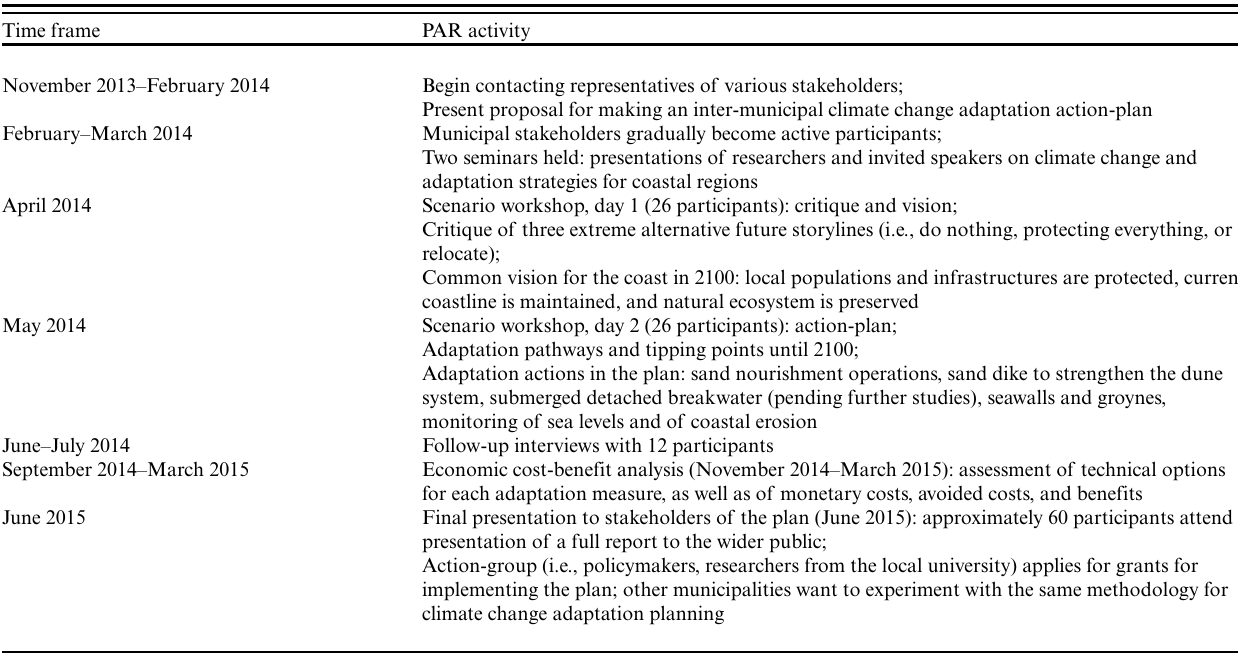
Table 2. Synthesis of participatory action-research on the coast of Ílhavo and Vagos (Case 1). Time